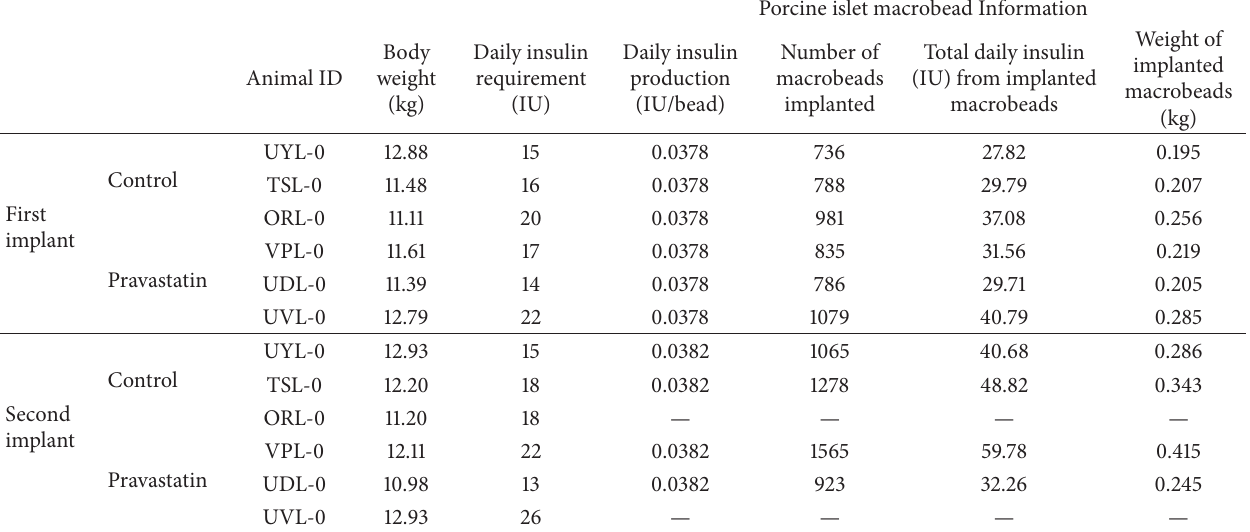
Table 1: Individual dog insulin requirements and islet macrobead information at first and second